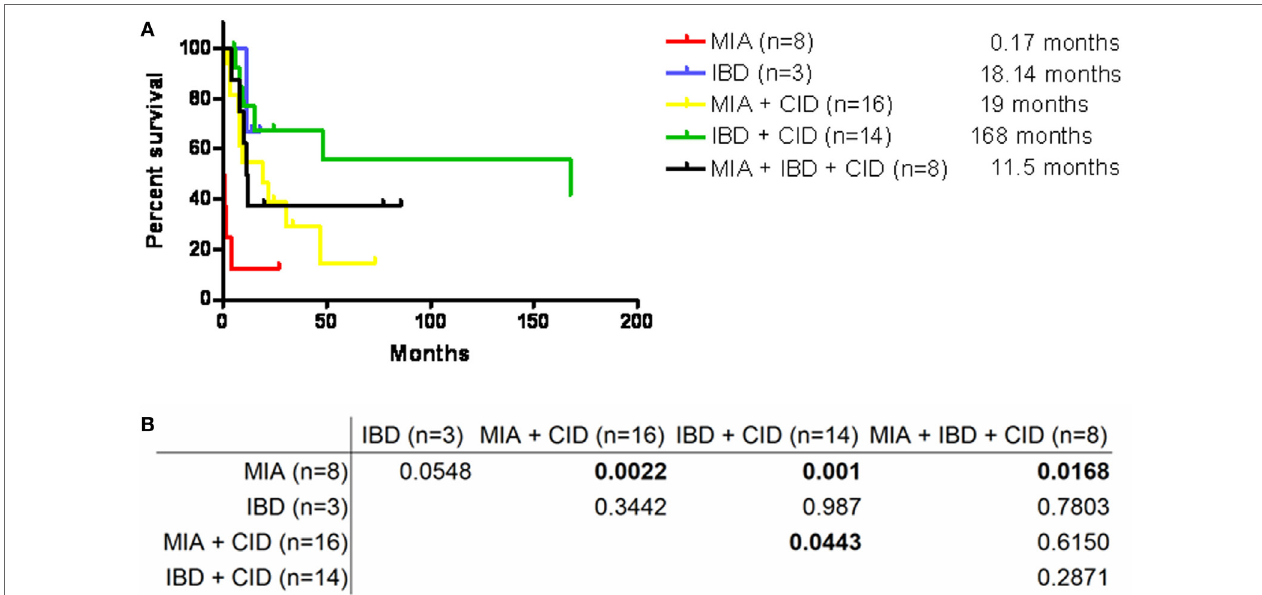
FigUre 5 | (a) Survival curve of the five phenotypes by Kaplan–Meier analysis showed (B) the significantly higher median lifespan in those with MIA + CID (median: 19 months), IBD + CID (168 months), and MIA + IBD + CID (11.5 months) compared to those with MIA alone (0.17 months); and also marginally significant with IBD + CID compared to MIA + CID. Abbreviations: MIA, multiple intestinal atresia; CID, combined T and B cell immunodeficiency; IBD, inflammatory bowel